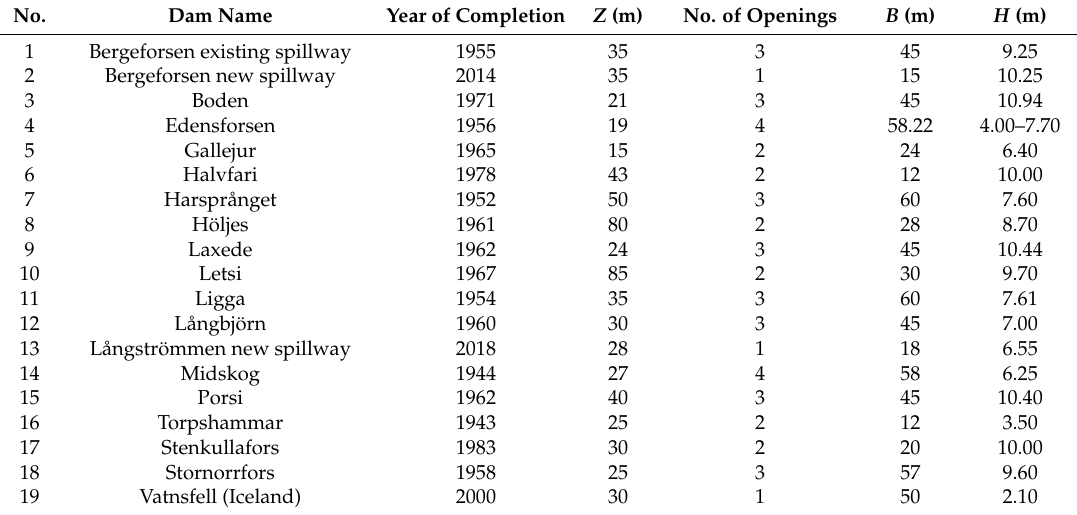
Table 2. Gated overflow spillways included.